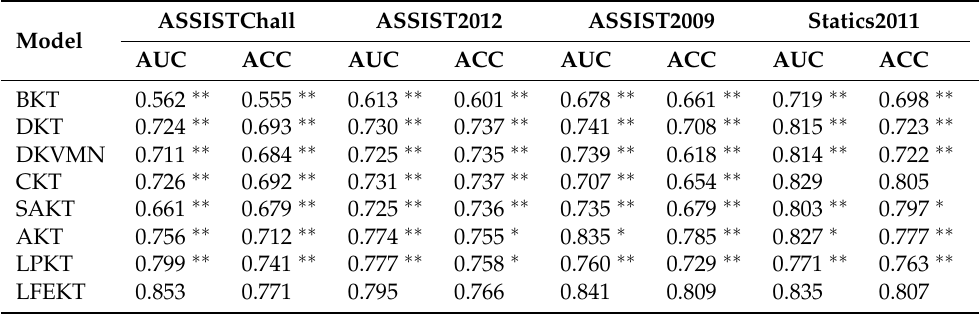
Table 3. Results of the comparison methods on performance prediction. We denote by “*” and “**” that LFEKT is significantly better than the corresponding baseline by p < 0.05 and p < 0.01,